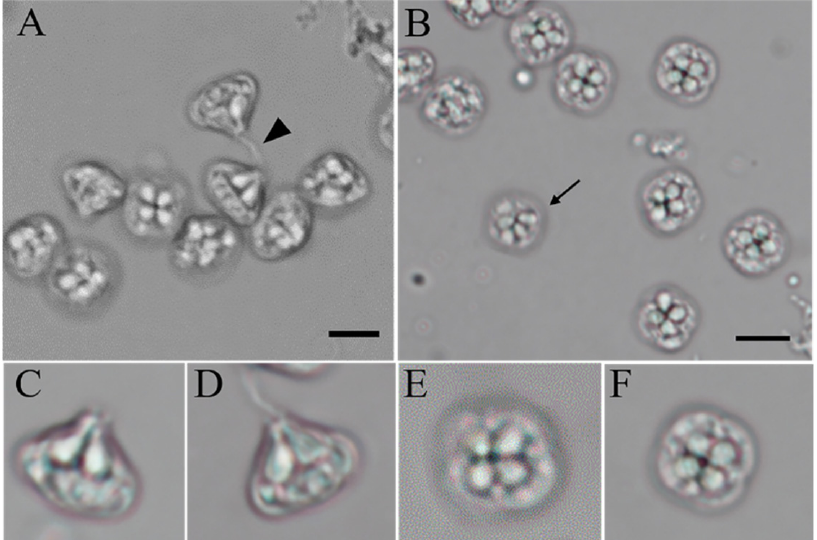
Figure 2. Light DIC microscopy of mature spores of Kudoa from large yellow croaker. ( A , B ) Spores of Kudoa . Note the protruding polar filament (black arrowhead) and aberrant spores with five polar capsules (black arrow). ( C , D ) Apical view of a single spore. ( E , F ) Lateral view of a single spore. All photographs are the same magnification. Scale bar = 5 µm.